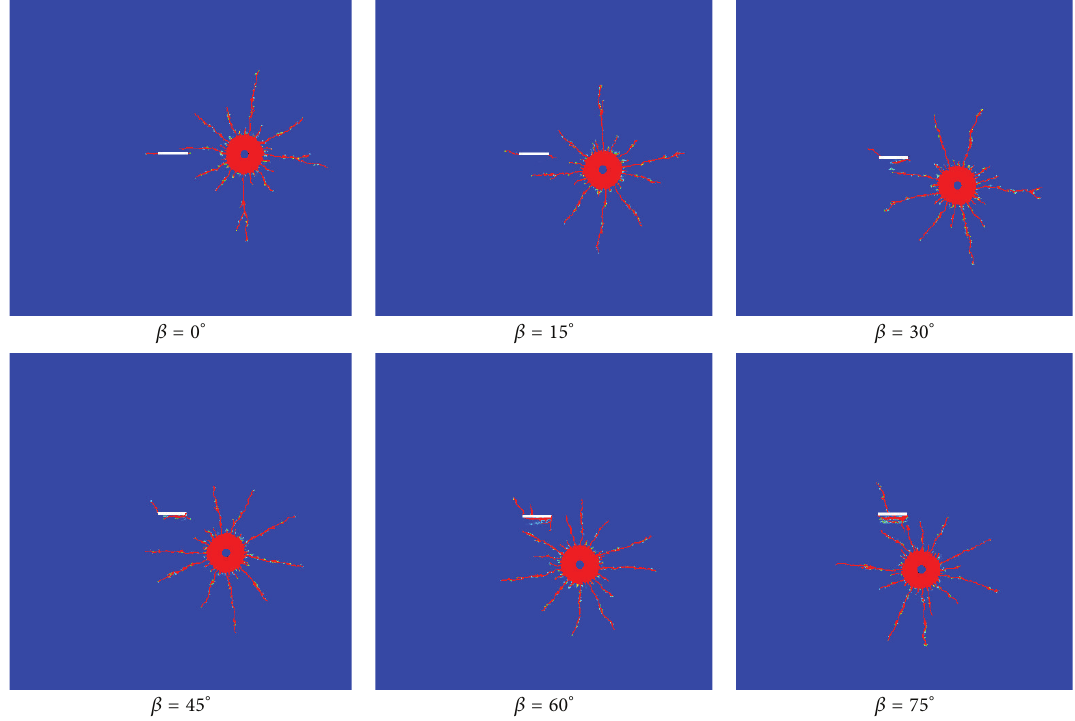
Figure 9: Material status of rock samples as a function of degree 𝛽 at t = 80 us after detonation in the